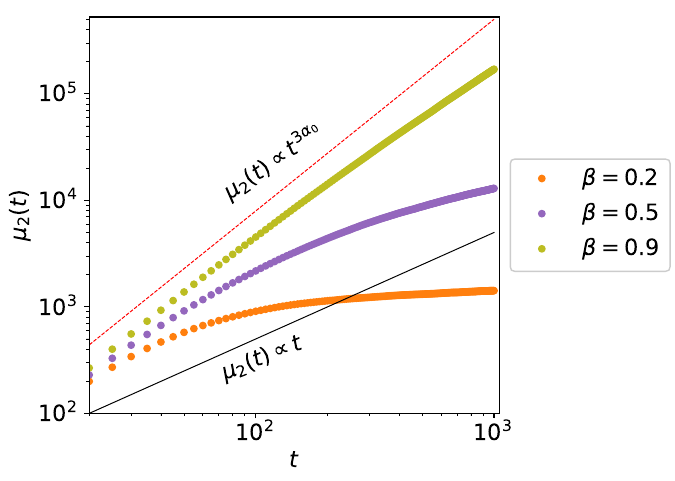
Figure 4. Plots of second moments for Monte Carlo simulated trajectories. Each value of β has N = 10 4 trajectories. The parameters used were α 0 = 0.6, ν = 1, λ = 0.1 and τ 0 = 1. For clarity, we added the black solid line which corresponds to the second moment of normal diffusion.